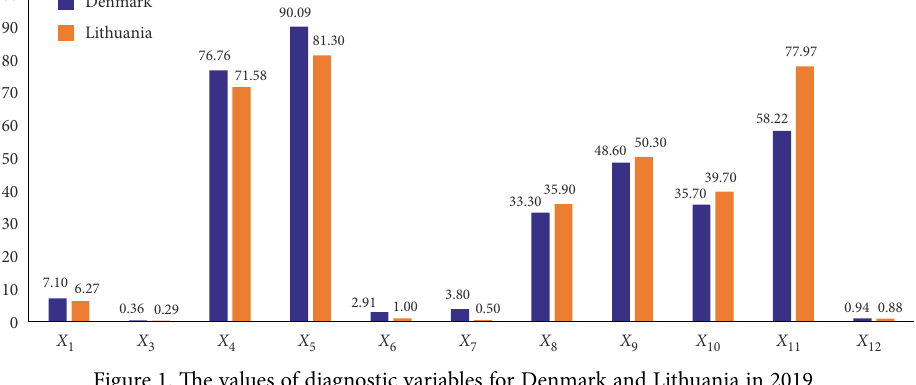
Figure 1. The values of diagnostic variables for Denmark and Lithuania in 2019